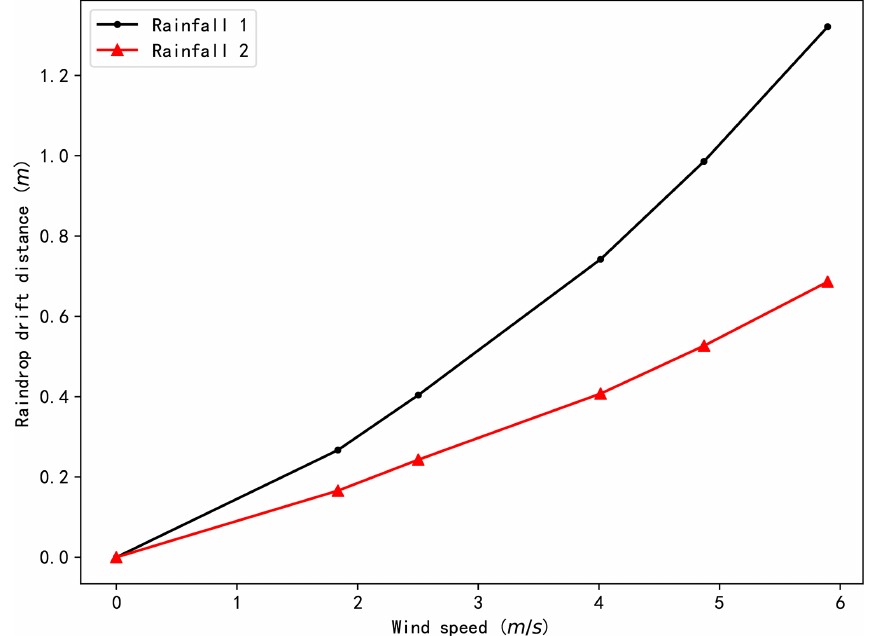
Figure 10. The wind drift of raindrops under different wind speeds under rainfalls 1 and 2.